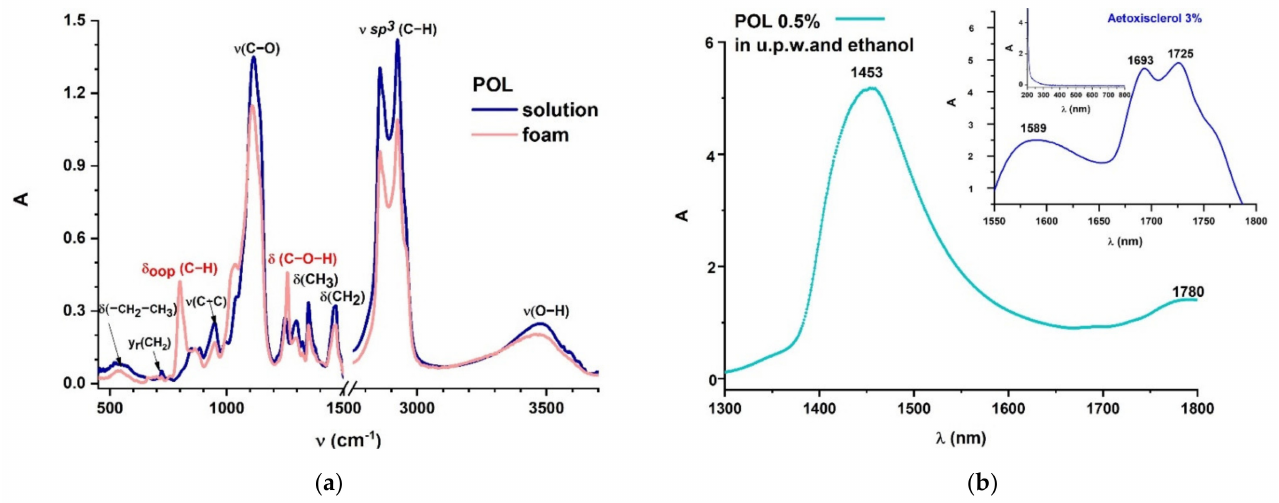
Figure 3. Optical characterization of POL: FTIR spectra of both solution and foam sample showing the vibrational changes of molecules induced by foam generation procedure (Tessari’s double syringe method) ( a ), and UV-Vis-NIR absorption spectra, with the spectrum of commercially available Aetoxisclerol (Kreussler Pharma) ( b